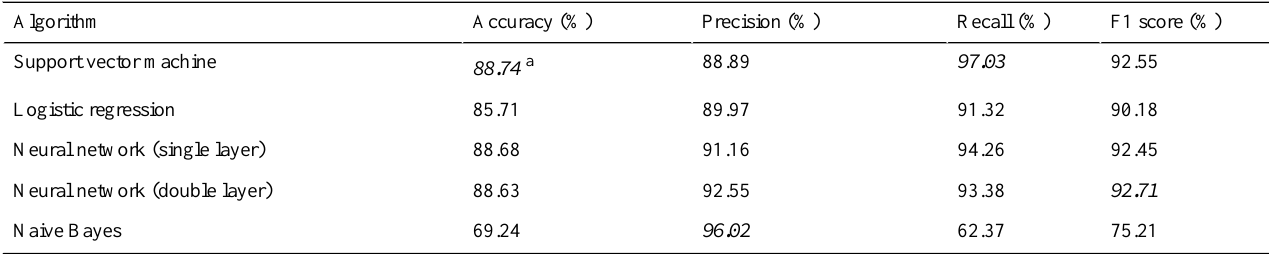
Table 5. Classification results for the first set of